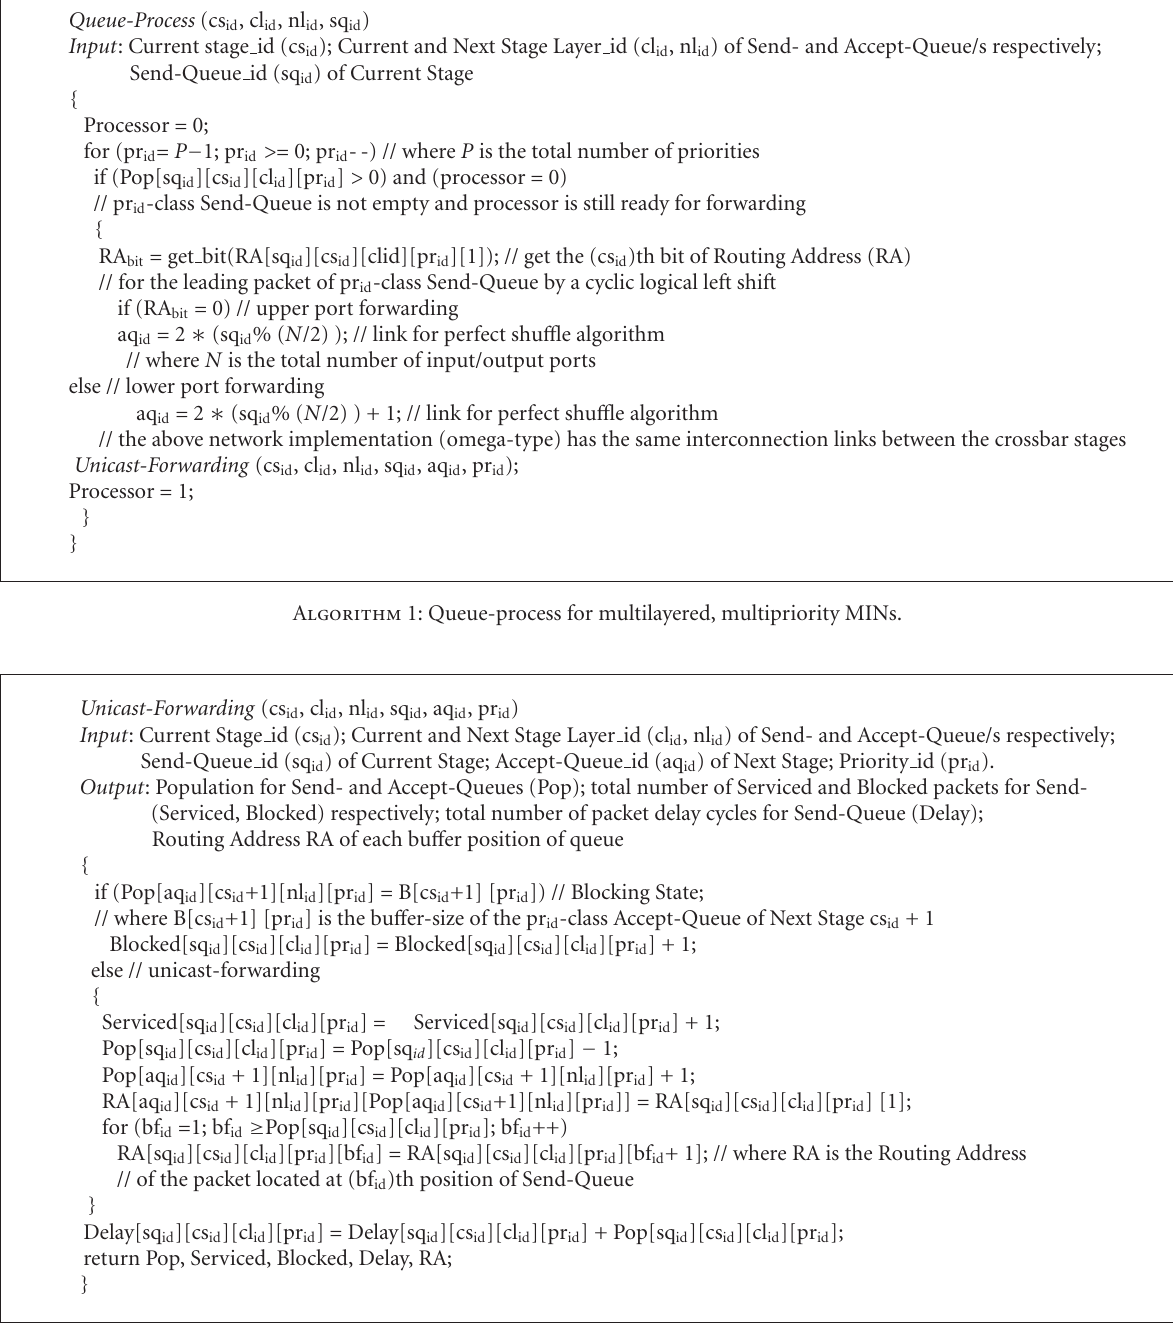
Algorithm 2: Unicast-forwarding for multilayered, multipriority